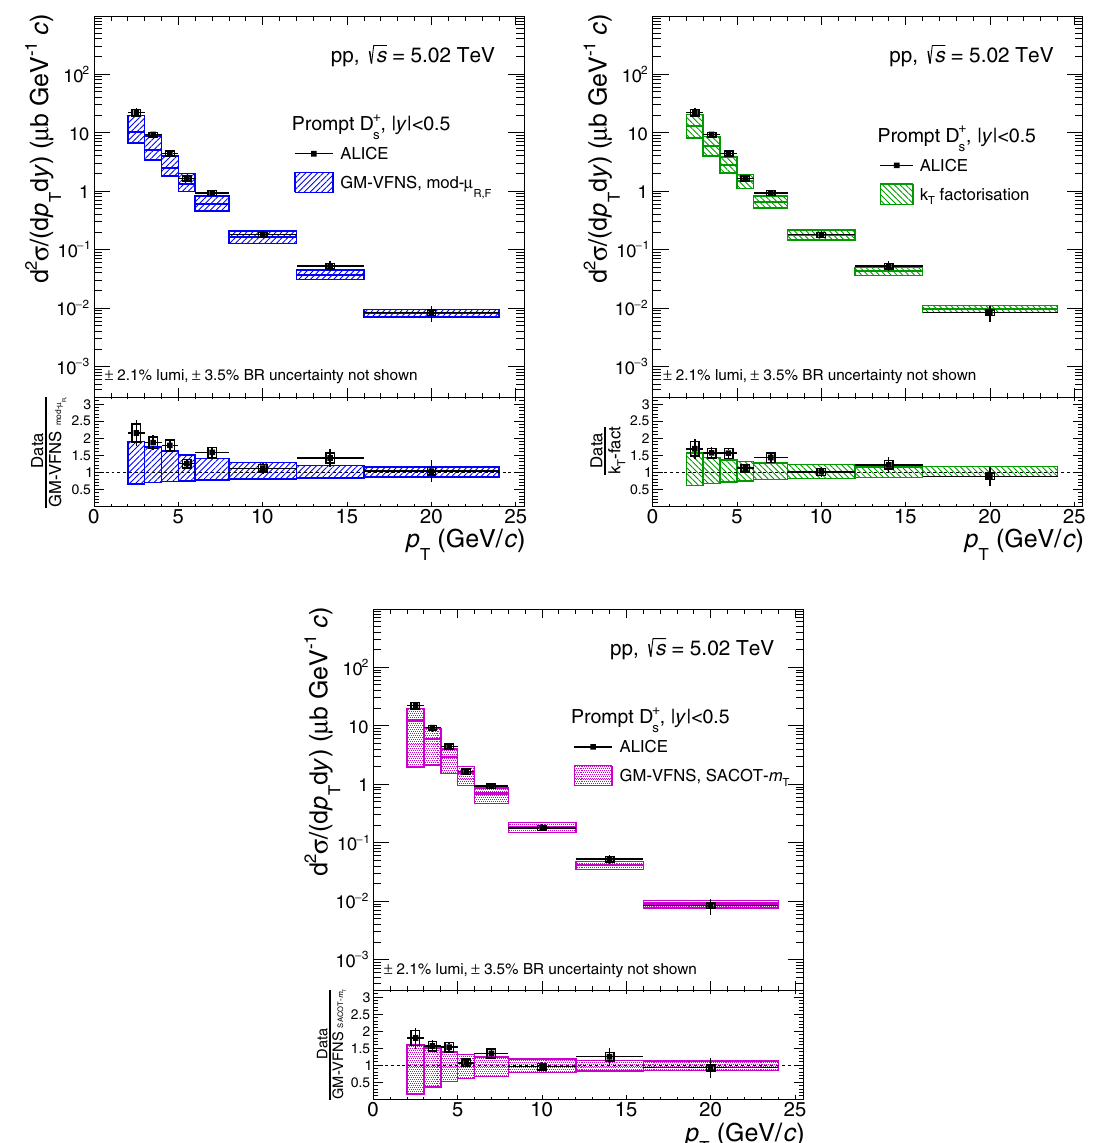
Fig. 11 p T -differential production cross sections for prompt D + s meson compared to GM-VFNS(mod- μ R , F ) [39,40], GM-VFNS(SACOT- m T ) [6], and k T -factorisation [41] pQCD calculations. The ratios of the data to the theoretical predictions are shown in the lower part of each panel